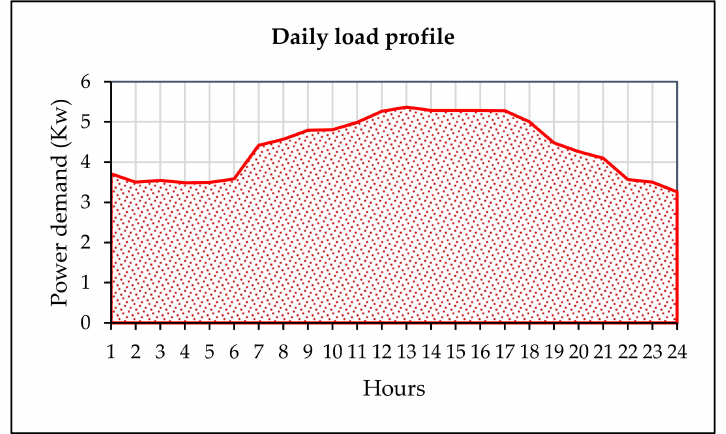
Figure 7. The building’s daily average load profile in January 2016. Courtesy of EDM